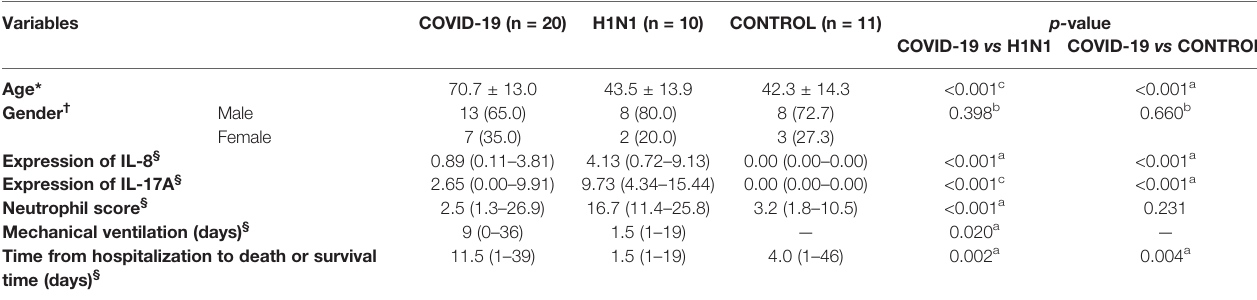
TABLE 1 | Sociodemographic and clinicopathological characteristics in the study